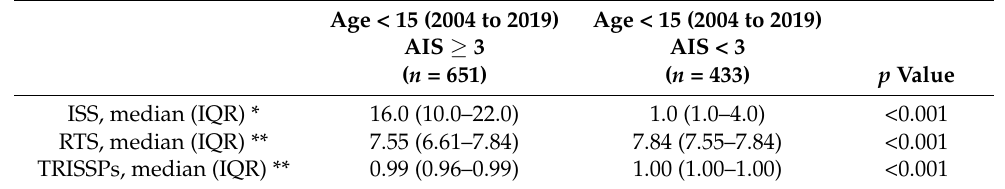
Table 4. Comparison of the ISS, RTS, and TRISSPS in patients aged < 15 years between those with an AIS score ≥ 3 and those with an AIS score < 3 (2004–2019). * The median value for an AIS score ≥ 3 was significantly higher than that for an AIS score < 3. ** The median value for an AIS score ≥ 3 was significantly lower than that for an AIS score <